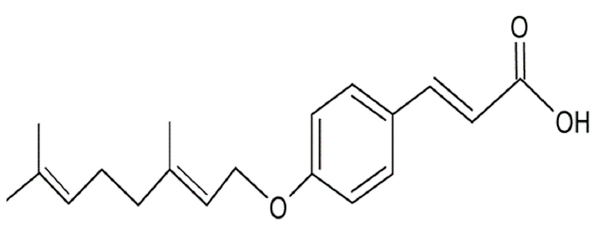
Figure 1. Chemical structure of 7-geranyloxycinnamic acid.